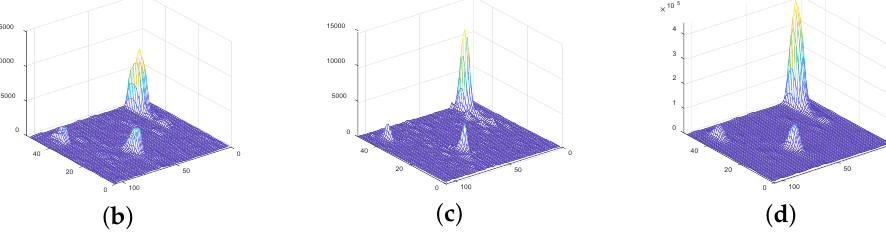
Figure 6. Target enhancement results. ( a ) original small target slices; ( b ) results of the MVWIE method; ( c ) results of the FMPCM method; ( d ) results of the proposed